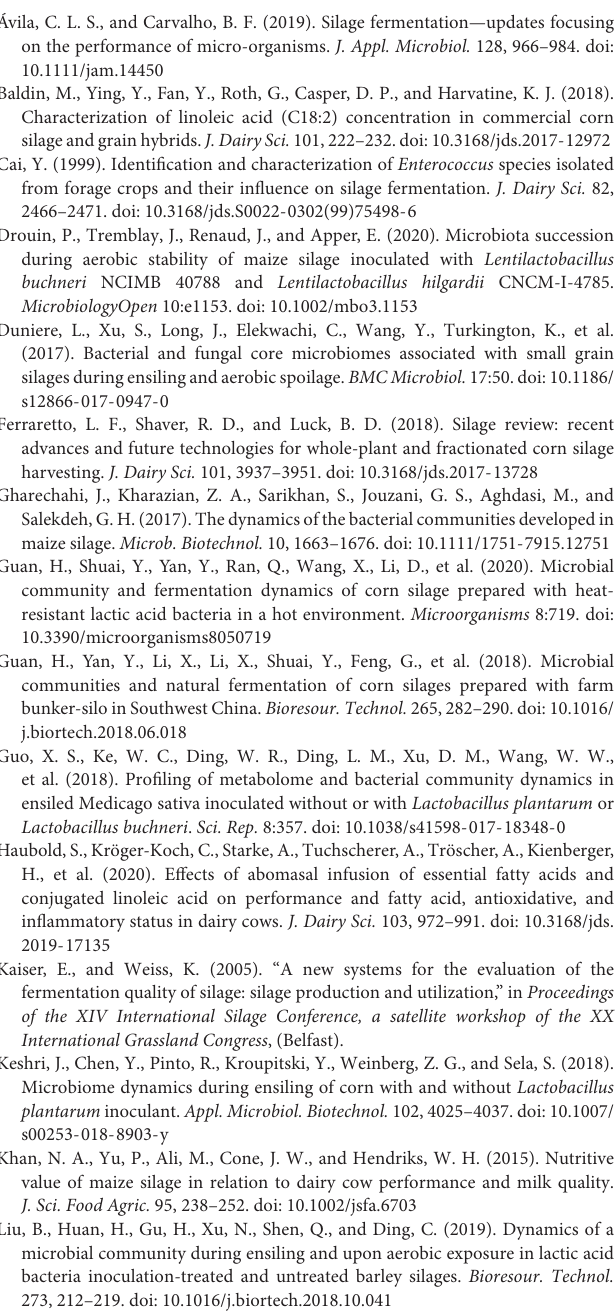
(D) . H, ensiled whole corn plants with a high moisture content (680 g/kg) harvested at the one-third milk-line stage; L, ensiled whole corn plants with a low moisture content (620 g/kg) harvested at the two-thirds milk-line stage. Supplementary Table 4 | Fold-change concentrations (log 2 relative concentrations) of fatty acid and amino acid in whole-plant corn silages during with a low moisture content (620 g/kg) harvested at the two-thirds milk-line